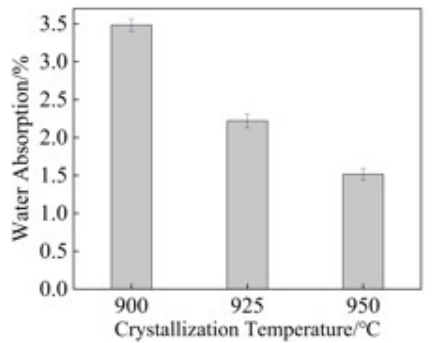
Figure 6. Effects of crystallization temperature on the water absorption of the microcrystalline glass.